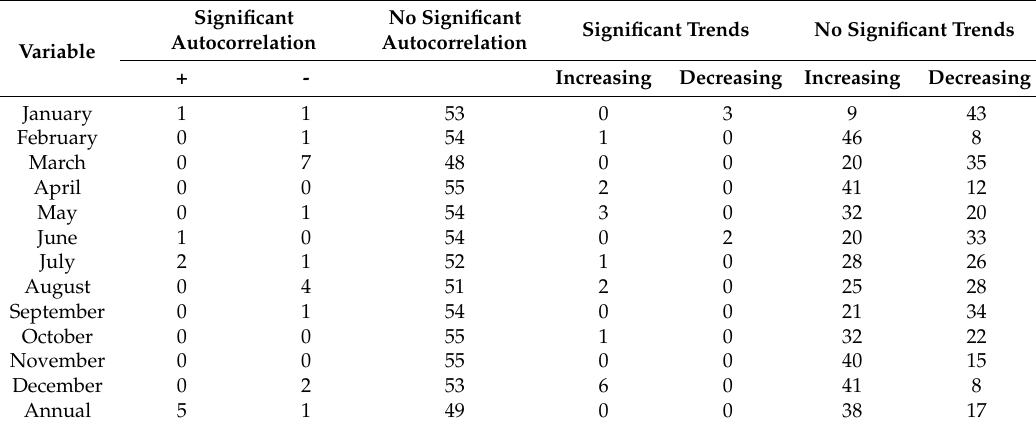
Figure 5. Maps showing the spatial patterns of Sen’s slope (mm/year) and Z statistic using modMK1 at 5% significance level for monthly and annual precipitation across South Korea. Table 1. Summary of the number of stations showing significant and non-significant lag-1 autocorrelation, and significant and non-significant trends across South Korea.